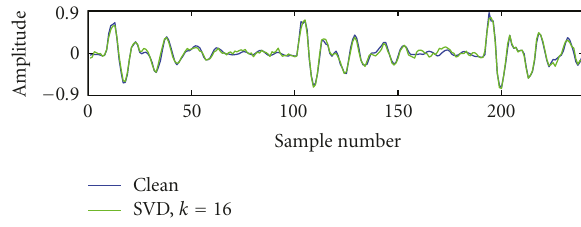
Figure 6: Comparison of the clean signal and the SVD-based MV estimate for k =